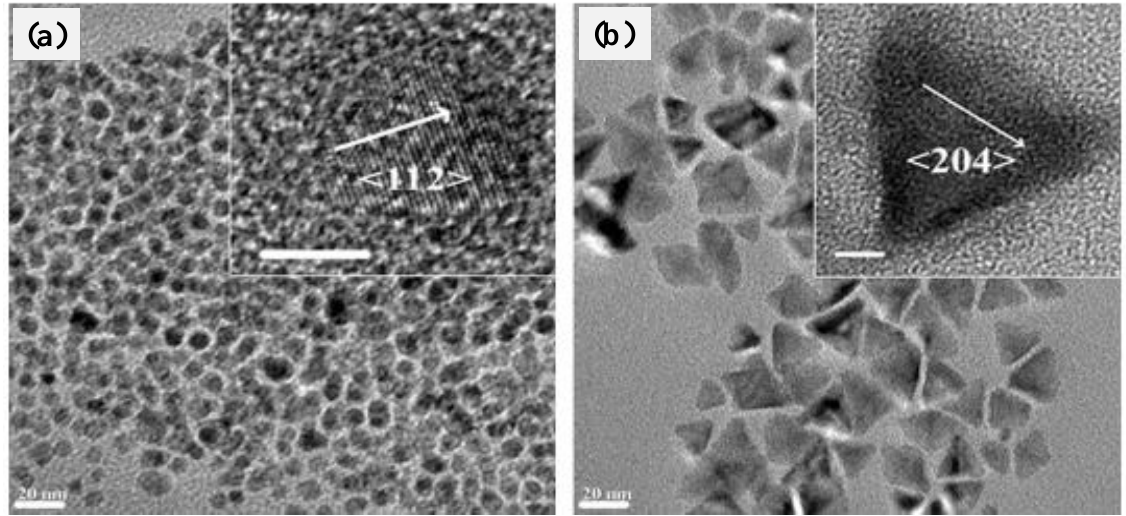
Figure 25. TEM of CuFeS 2 nanocrystals with ( a ) spherical and ( b ) pyramidal morphology (HRTEM images shown in the insets). Reproduced with permission [216]. Copyright 2010 Elsevier.